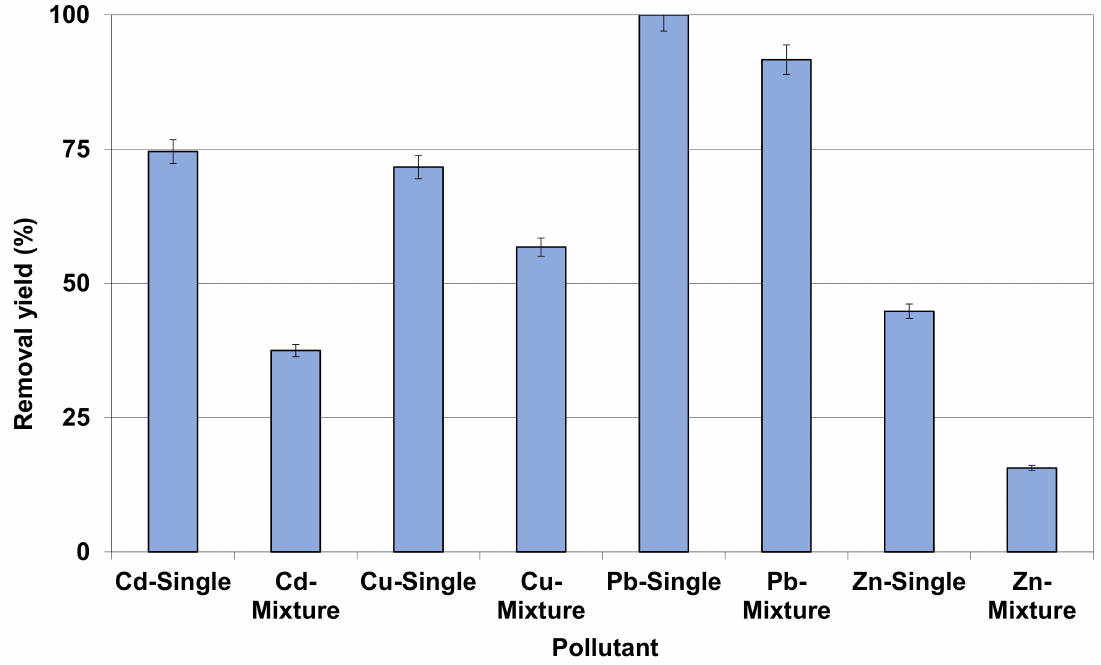
Figure 5. Cd, Cu, Pb and Zn removal yield in single and multicomponent systems (C 0 = 30 mg L − 1 for all metals; D = 2 g L − 1 ; t = 60 min; pH = 5; T = 20 ± 2 ◦